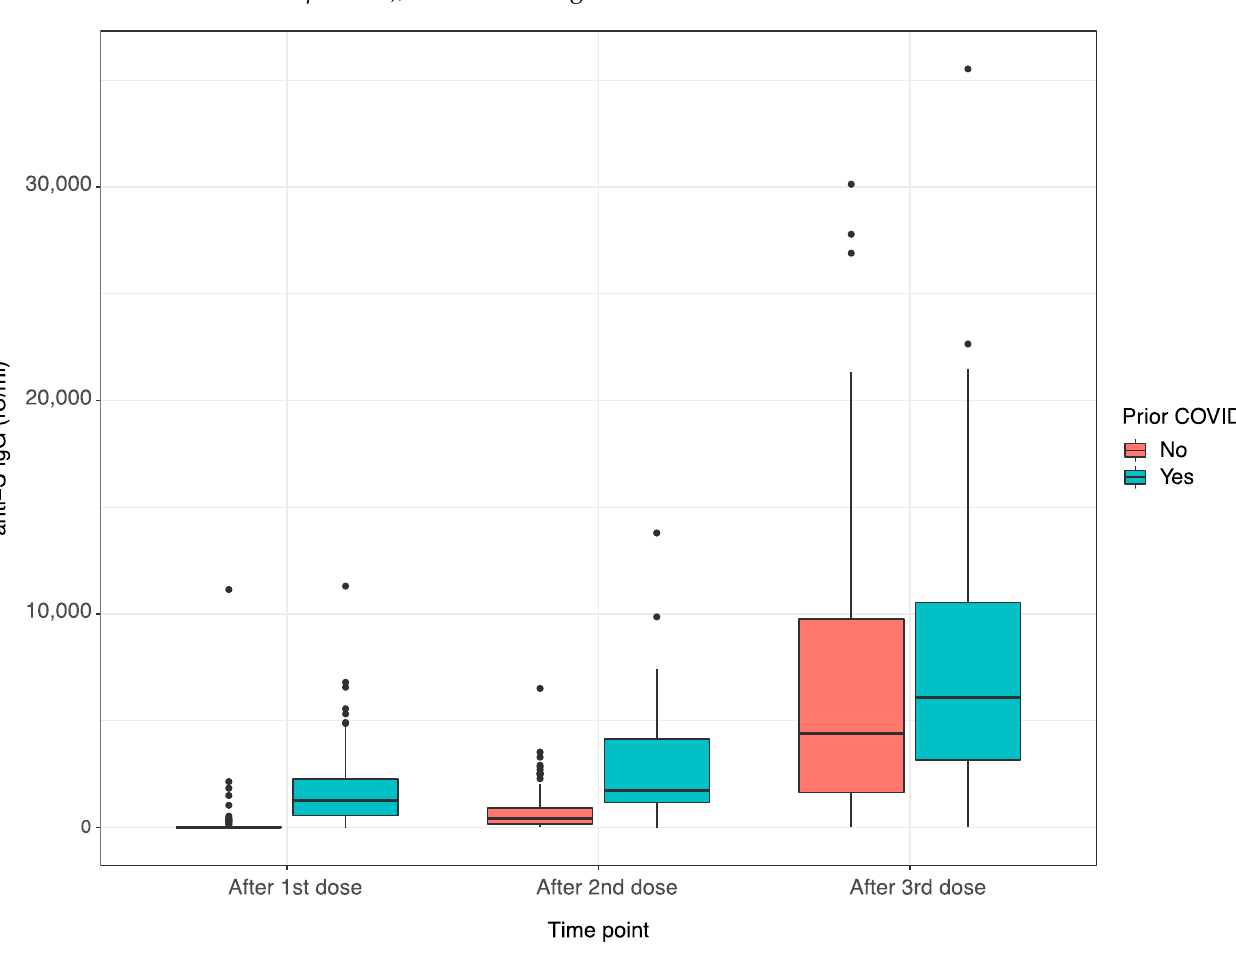
Table 3. Predictors of anti-S IgG waning. Results of a univariable and multivariable logistic regres- sion (OR odds ratio, CI confidence interval).